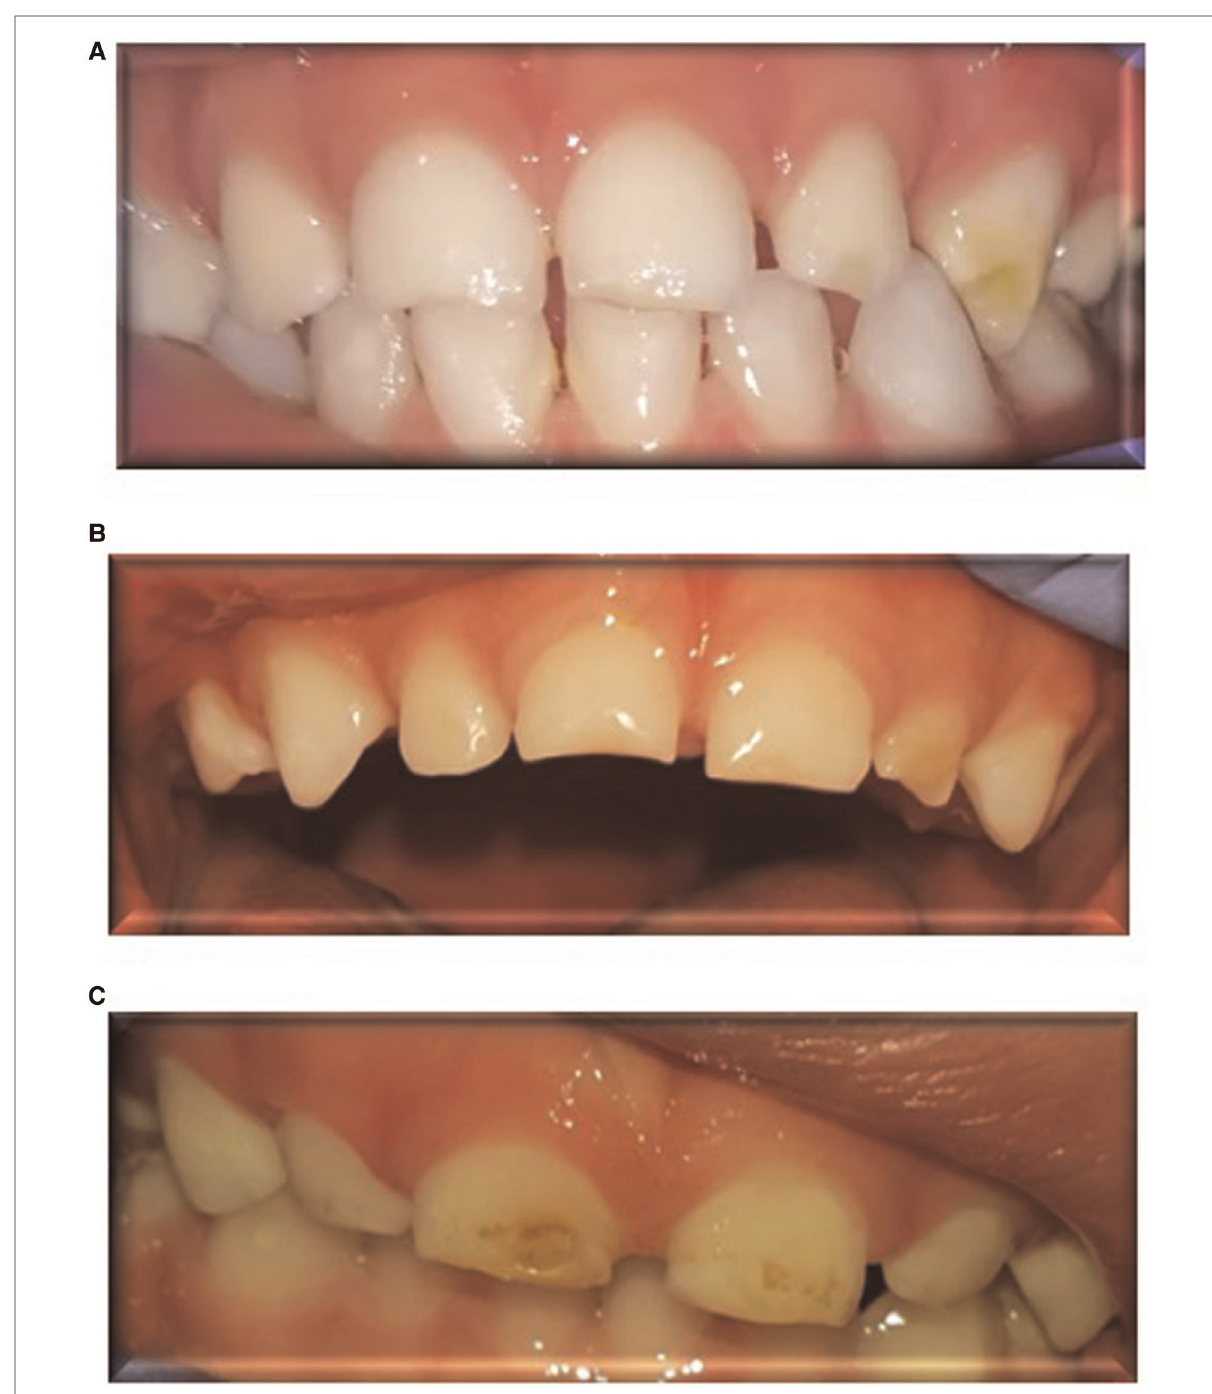
FIGURE 1 Clinical manifestations of developmental defects of enamel (DDE) in the front teeth of children born preterm. ( A ): DDE in the maxillary left lateral incisor and canine of a 34-month-old boy, born preterm at 25 gestational weeks, who had respiratory distress syndrome at birth, received surfactant, and was intubated for 2 days. ( B ): DDE in the central maxillary incisors and lateral left incisor of a 34-month-old boy, born preterm at 27 gestational weeks, who had respiratory distress syndrome at birth, received surfactant, and was intubated for 9 days. ( C ): DDE in the central maxillary incisors of a 31-month-old girl, born preterm at 30 gestational weeks, who had respiratory distress syndrome at birth, received surfactant, and was intubated for 3